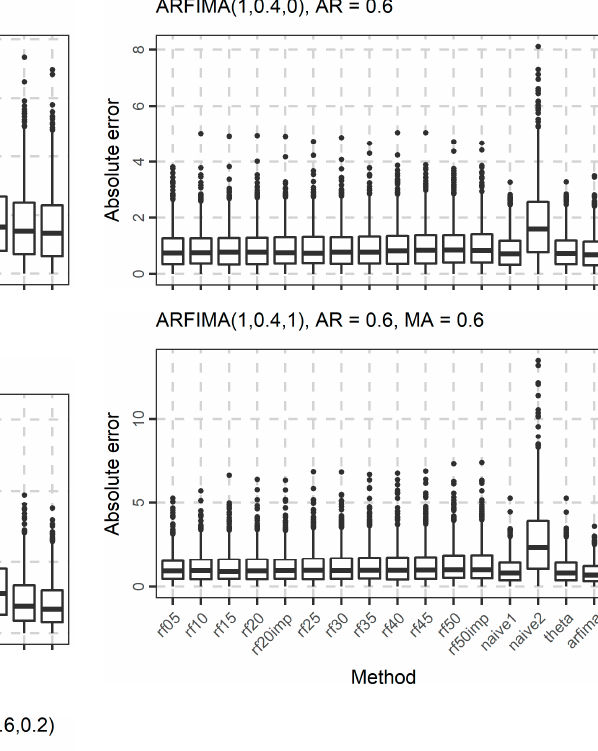
Figure 6. Boxplots of the absolute errors when forecasting the 101st value of 1000 simulated time series from each ARFIMA model used in the present study.